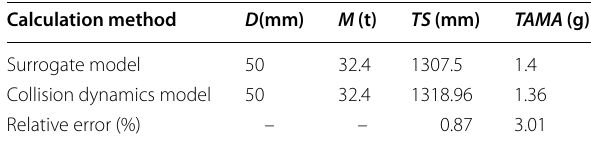
Table 13 Multi-objective optimal solution under the